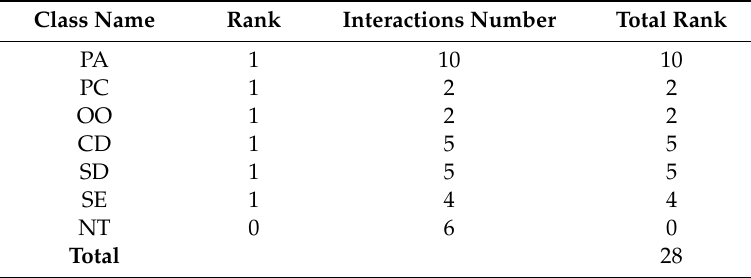
Table 13. A case study of FCS learners’ participation ranking for Group